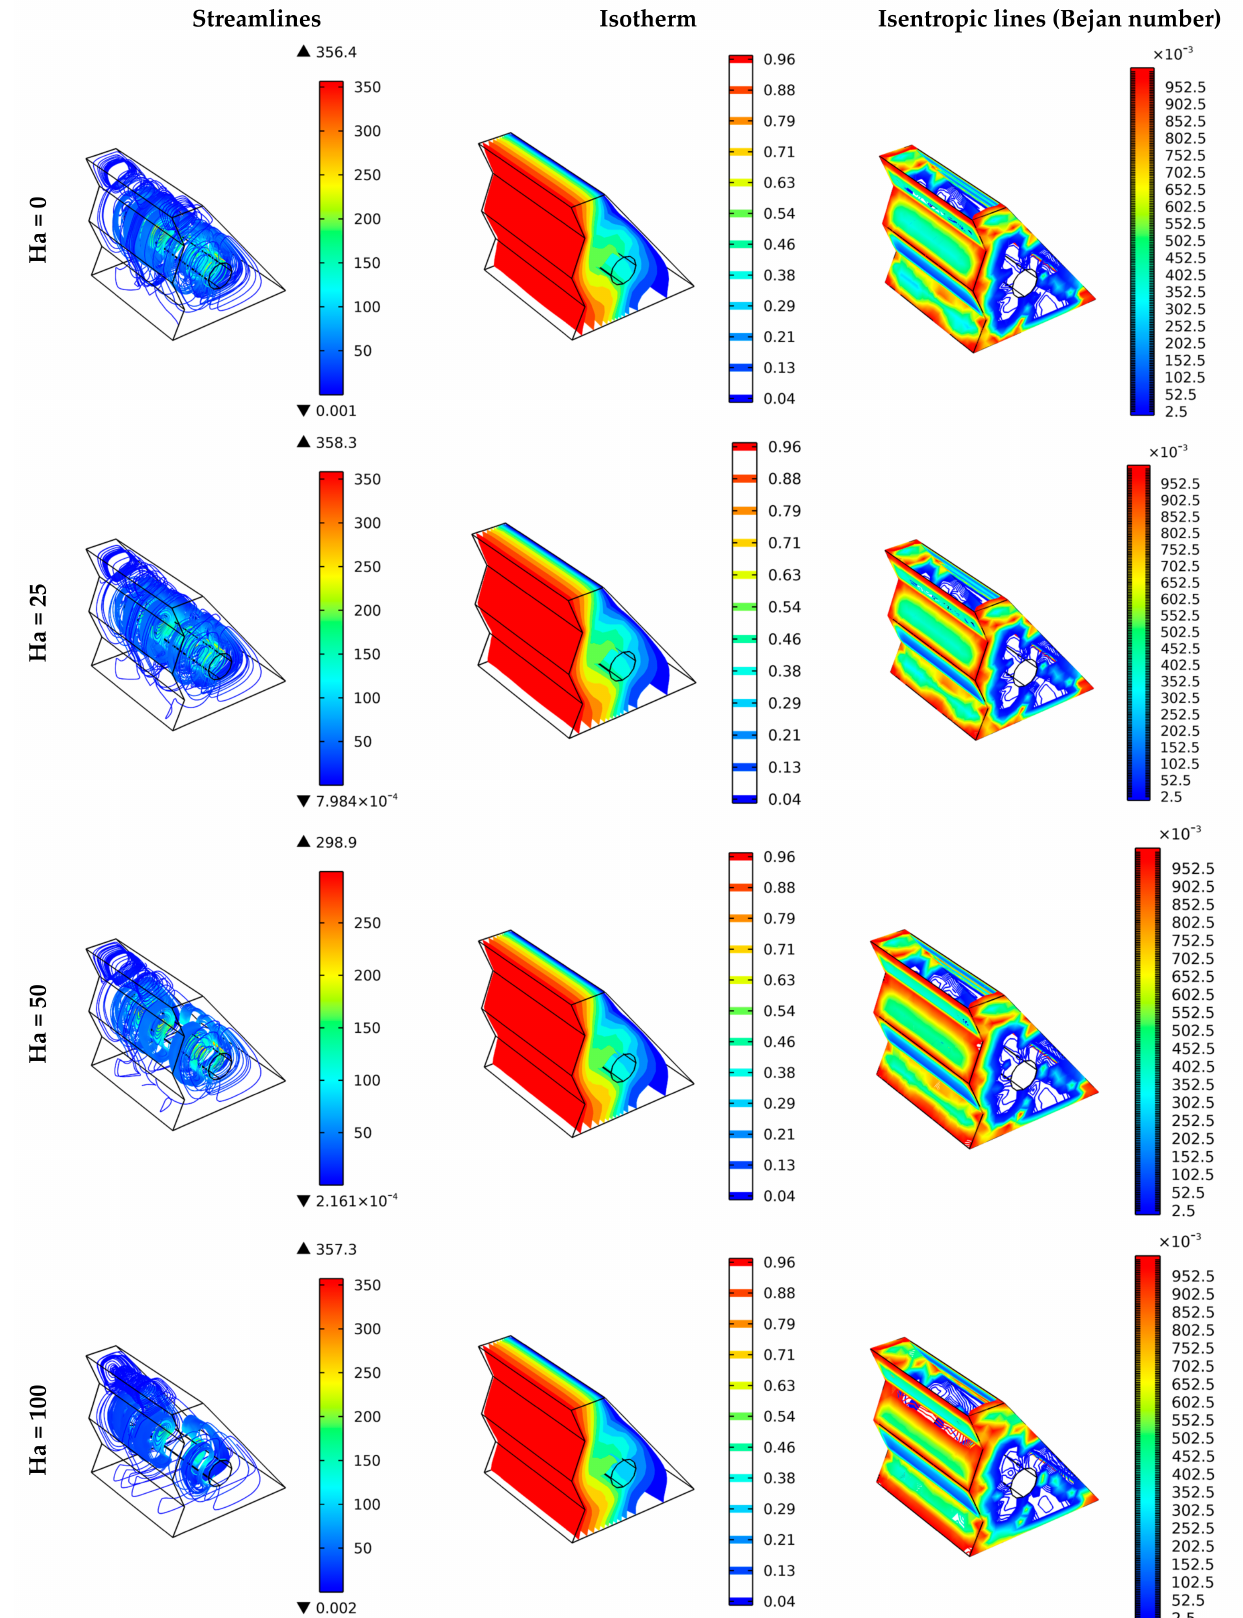
Figure 4. Three-dimensional surface plots to show the effect of the Hartmann number on the streamlines, temperature in terms of dimensionless isotherms, and Bejan